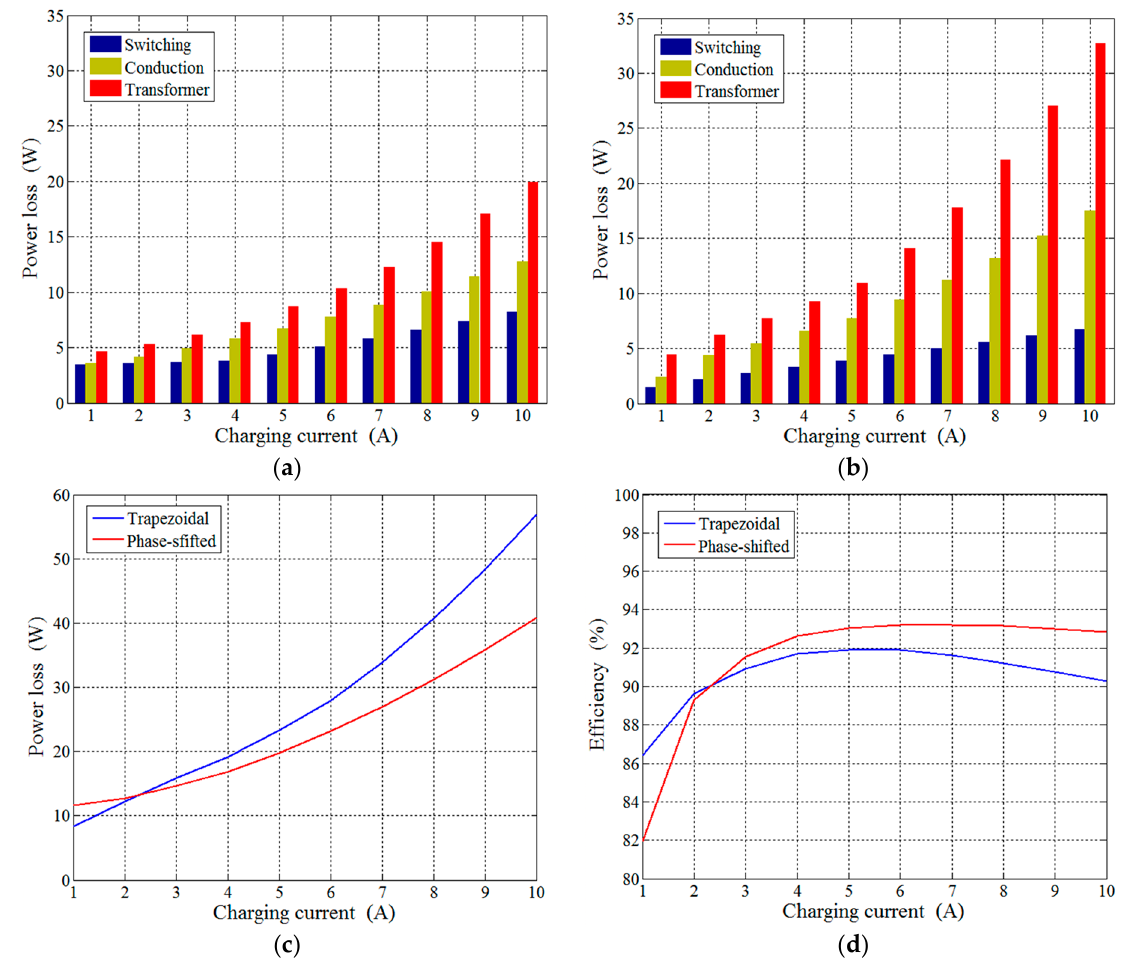
Figure 5. Simulation result of the power loss and efficiency. ( a ) Detailed loss with phase-shift; ( b ) Detailed loss with trapezoidal; ( c ) The curves of power loss; ( d ) Efficiency curve.